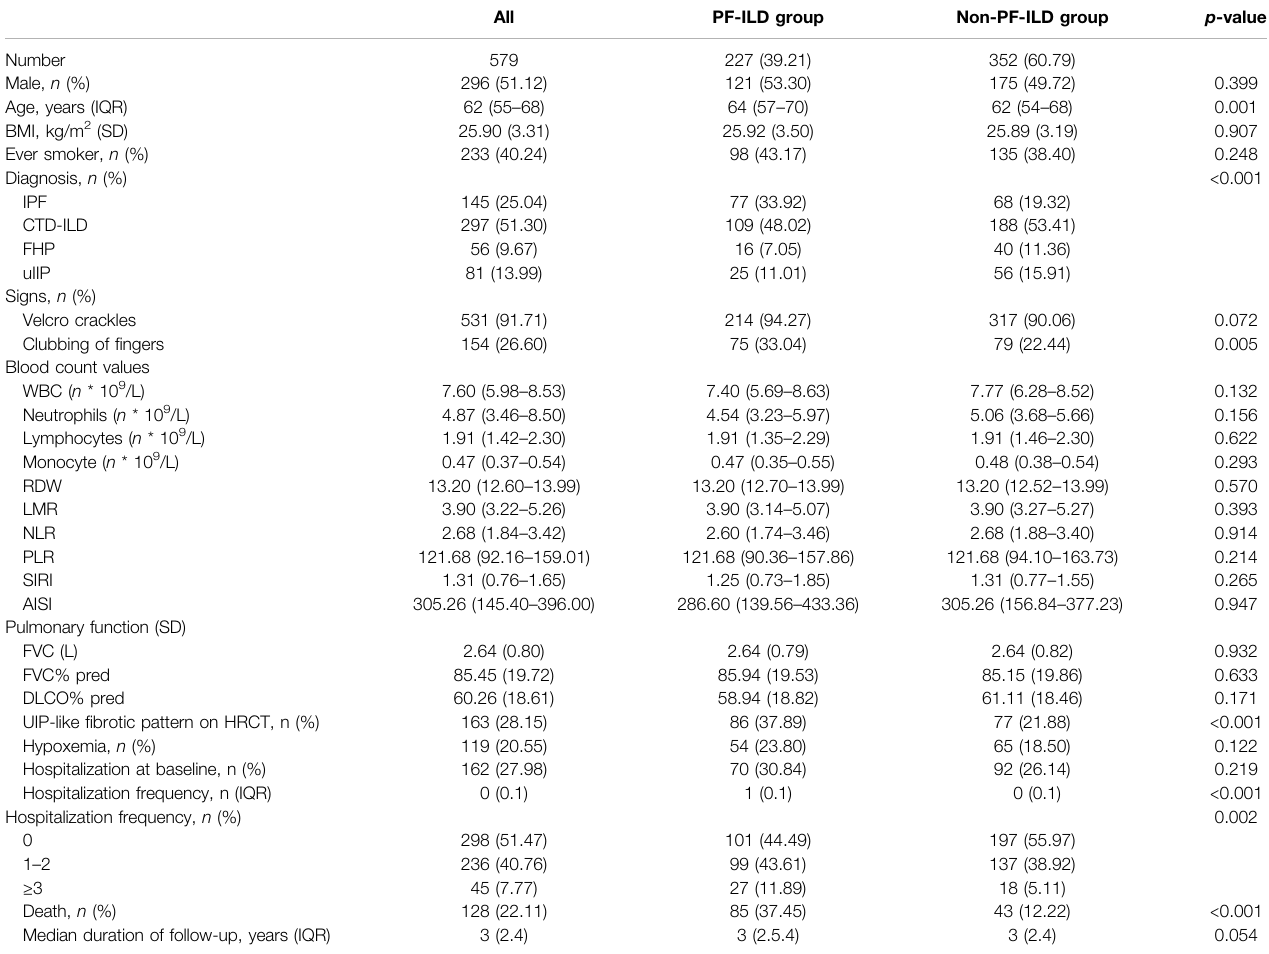
TABLE 1 | Demographics and clinical characteristics of the cohort.